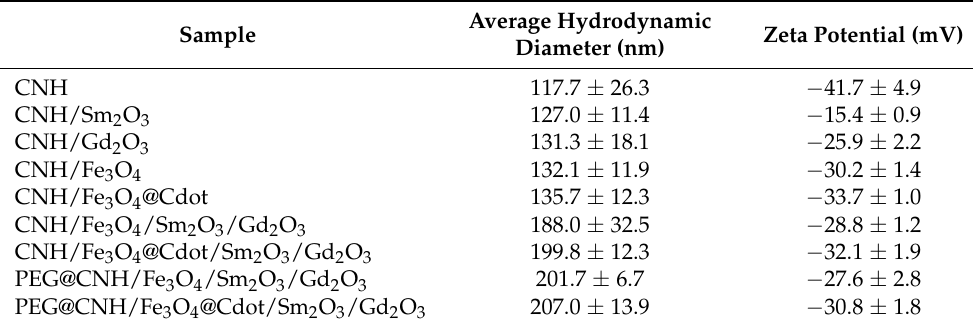
Table 1. Comparison of hydrodynamic size and zeta potential. The data are represented as means ± SD, ( n =